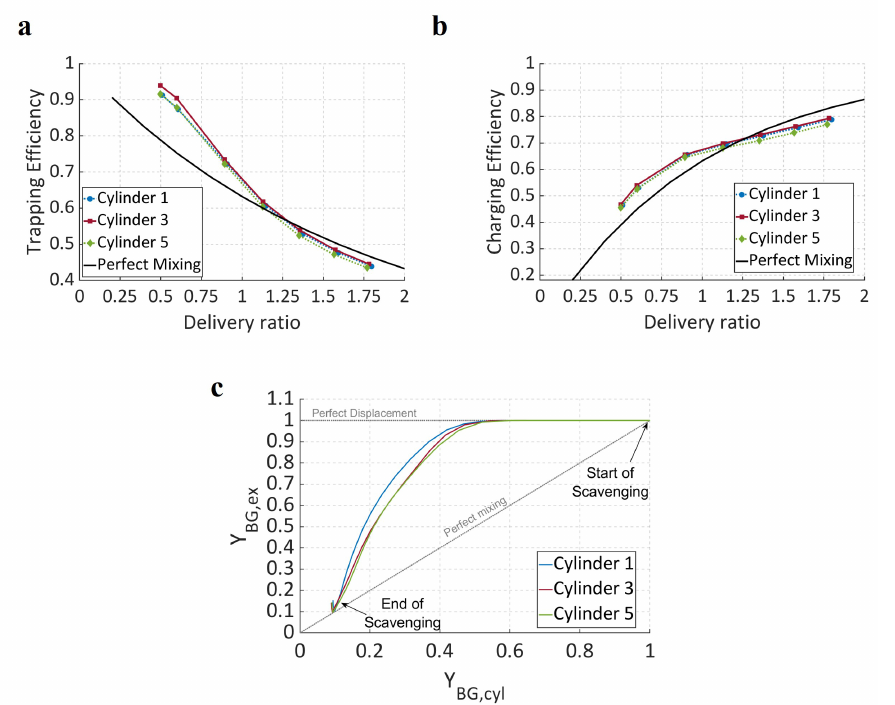
Figure 15. Influence of cylinders location in the bank on scavenging performances. ( a ) Trapping efficiency of the three cylinders. ( b ) Charging efficiency of the three cylinders. ( c ) Burned gas mass fraction in the exhaust ducts versus burned gas mass fraction in the cylinder for the three cases with G = G b .